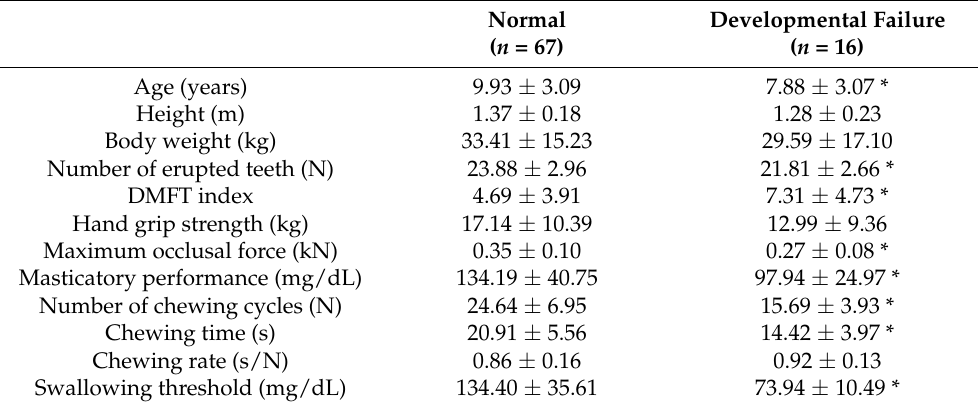
Table 5. Comparison of the development of swallowing threshold on age, height, body weight, dental status, hand grip strength, and masticatory function.